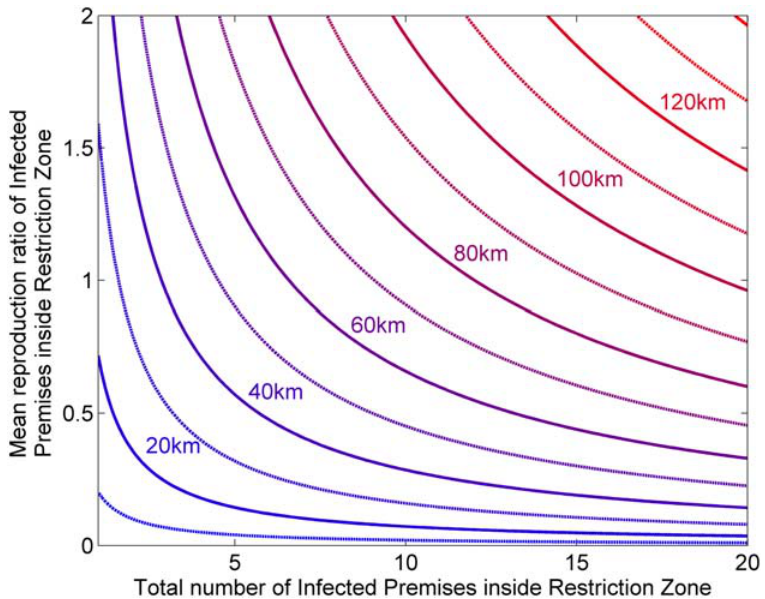
Figure 1. Required Restriction Zone radii to maintain the risk of escape below 1%, given the number of IPs I and the mean reproduction ratio R 0 of all IPs within the